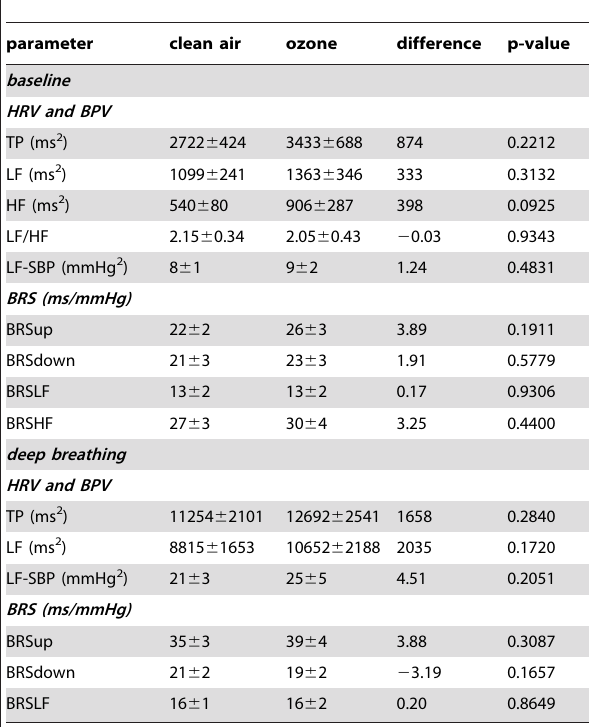
Table 4. Heart rate variability (HRV), blood pressure variability (BPV) and baroreflex sensitivity (BRS) data measured on both study days at rest and during deep